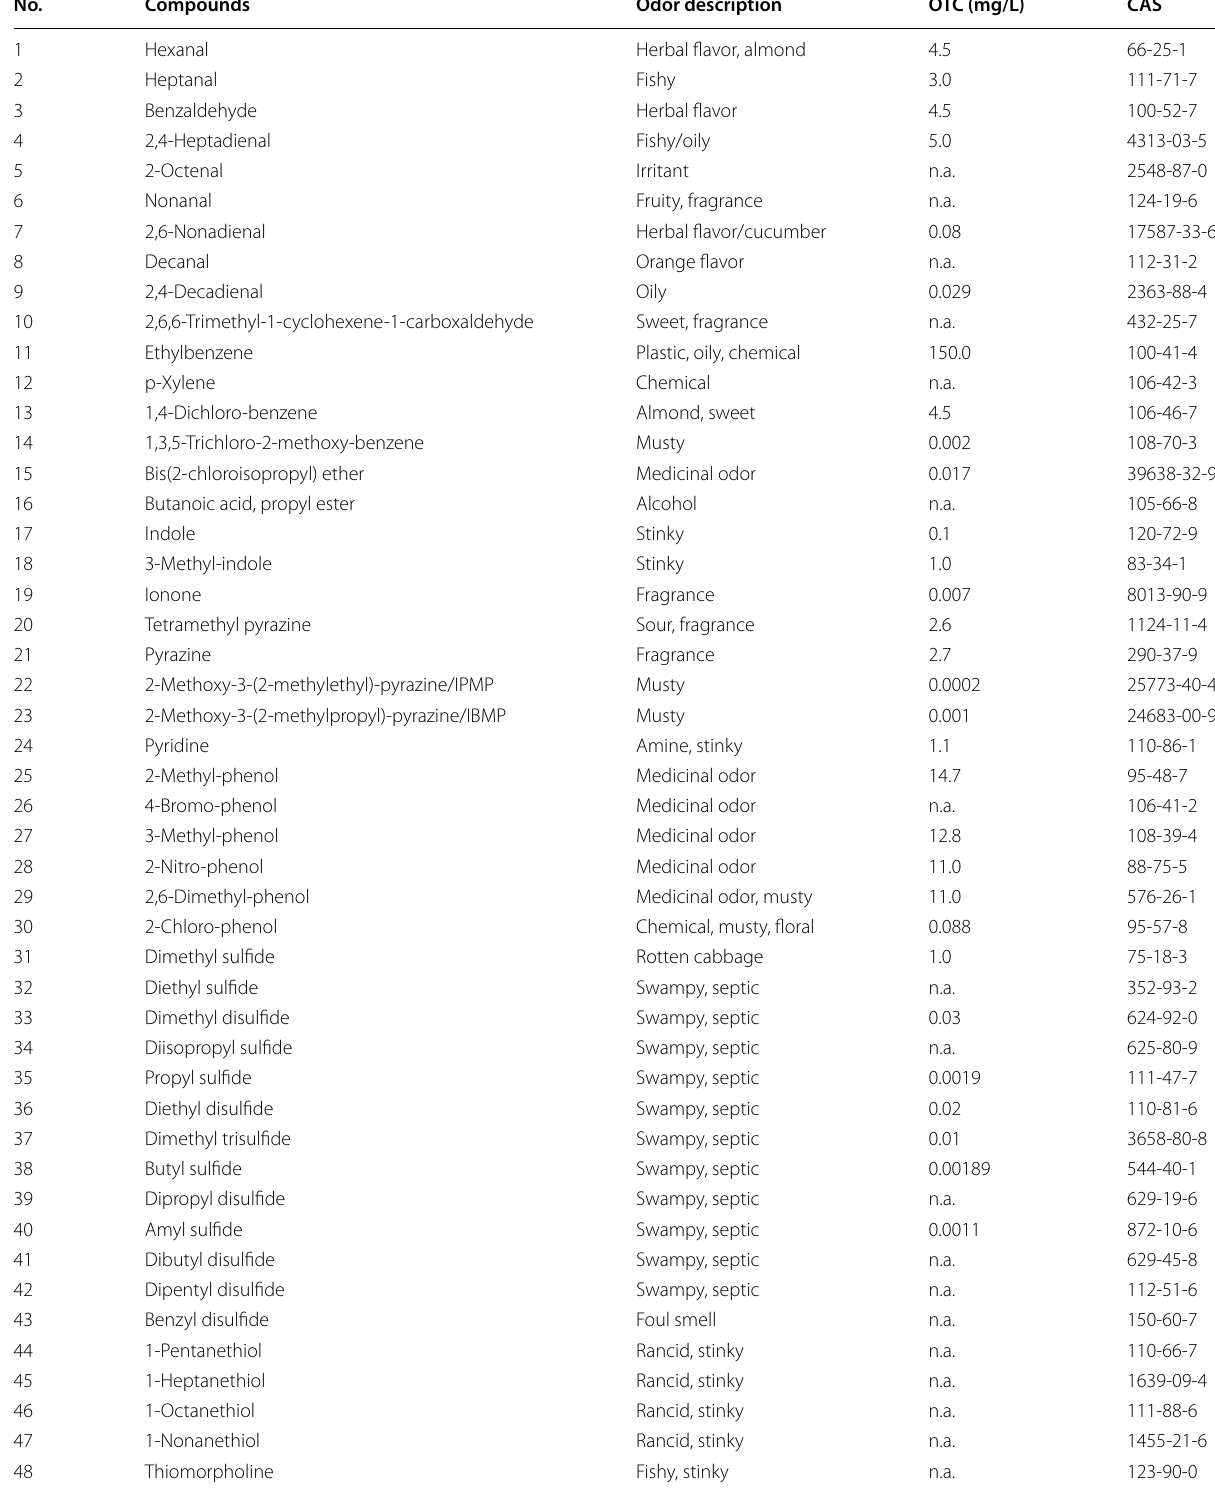
Table 2 Information of the 54 odor compounds analyzed by GC